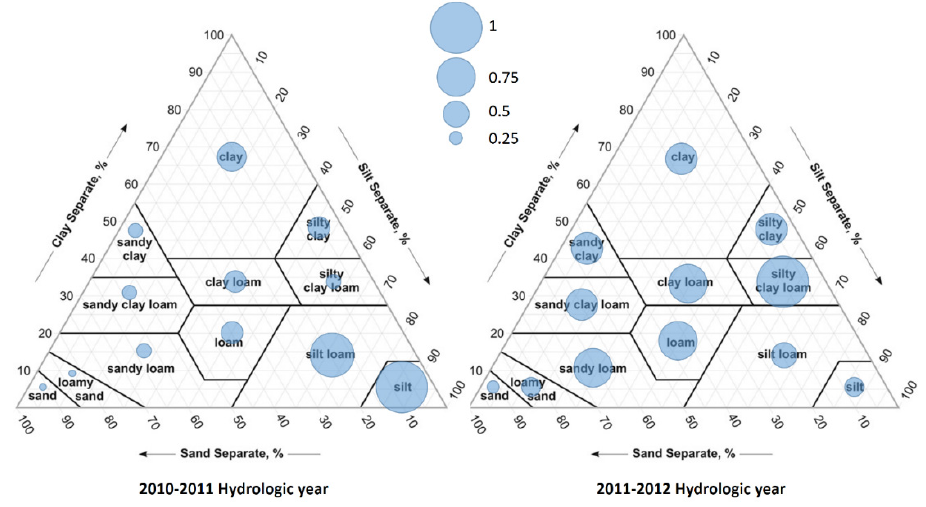
Figure 3. Freeze–thaw cycles for 1 cm depth, 2010–2011 and 2011–2012 hydrologic years. Results were normalized ranging from 0 to 1; each circle represents the scaled result. A bigger circle indicates the highest value in the metric.